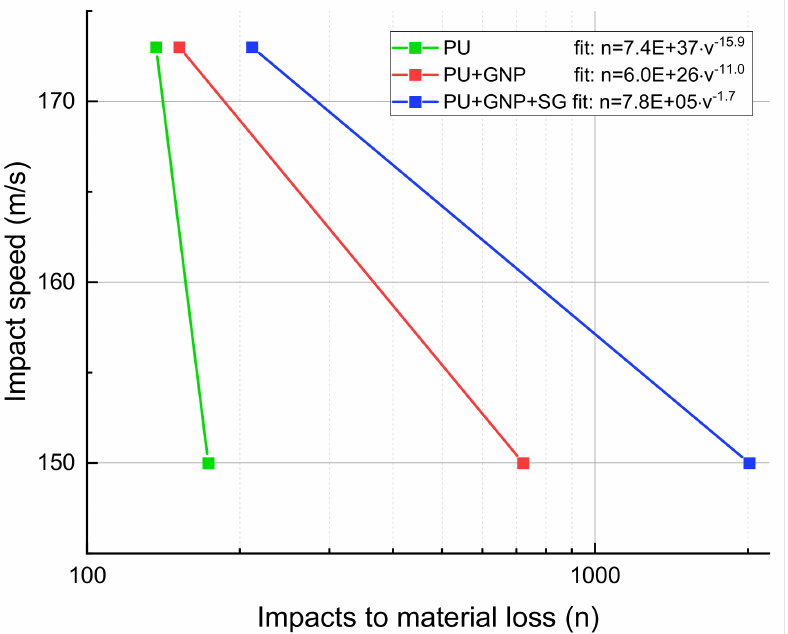
Figure 9. VN curves of PU, PU + GNP, and PU + GNP + SG tested at 173 and 150 m/s and fitted by a power curve. Damage was evaluated at the point of material loss. The lines correspond to the following cases: green line (left): PU, red line (middle): PU + GNP; blue line (right): PU + GNP +